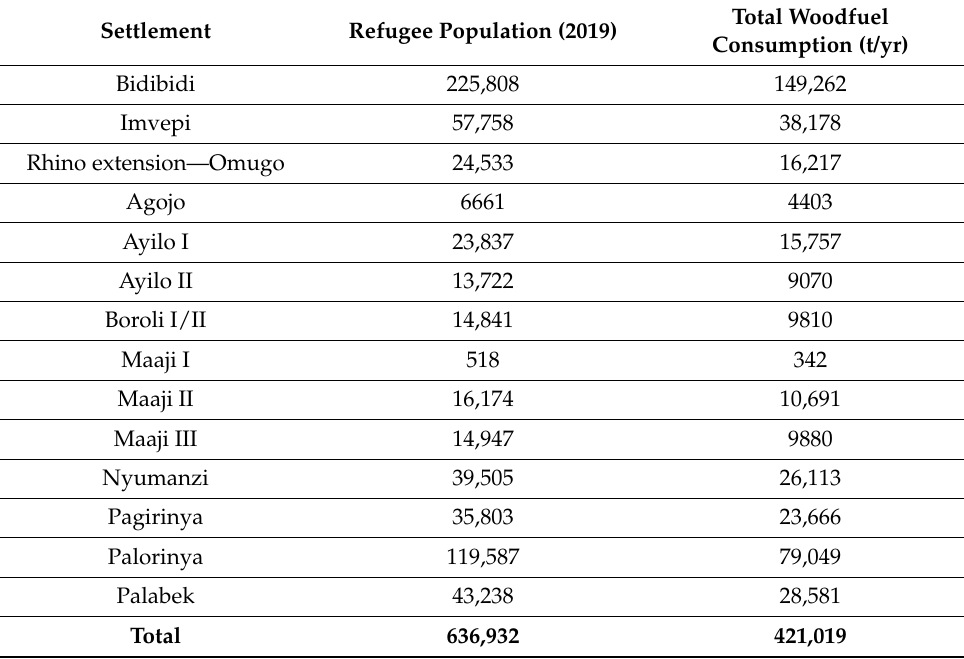
Table 6. Estimated total woodfuel consumption by the refugee population in northern